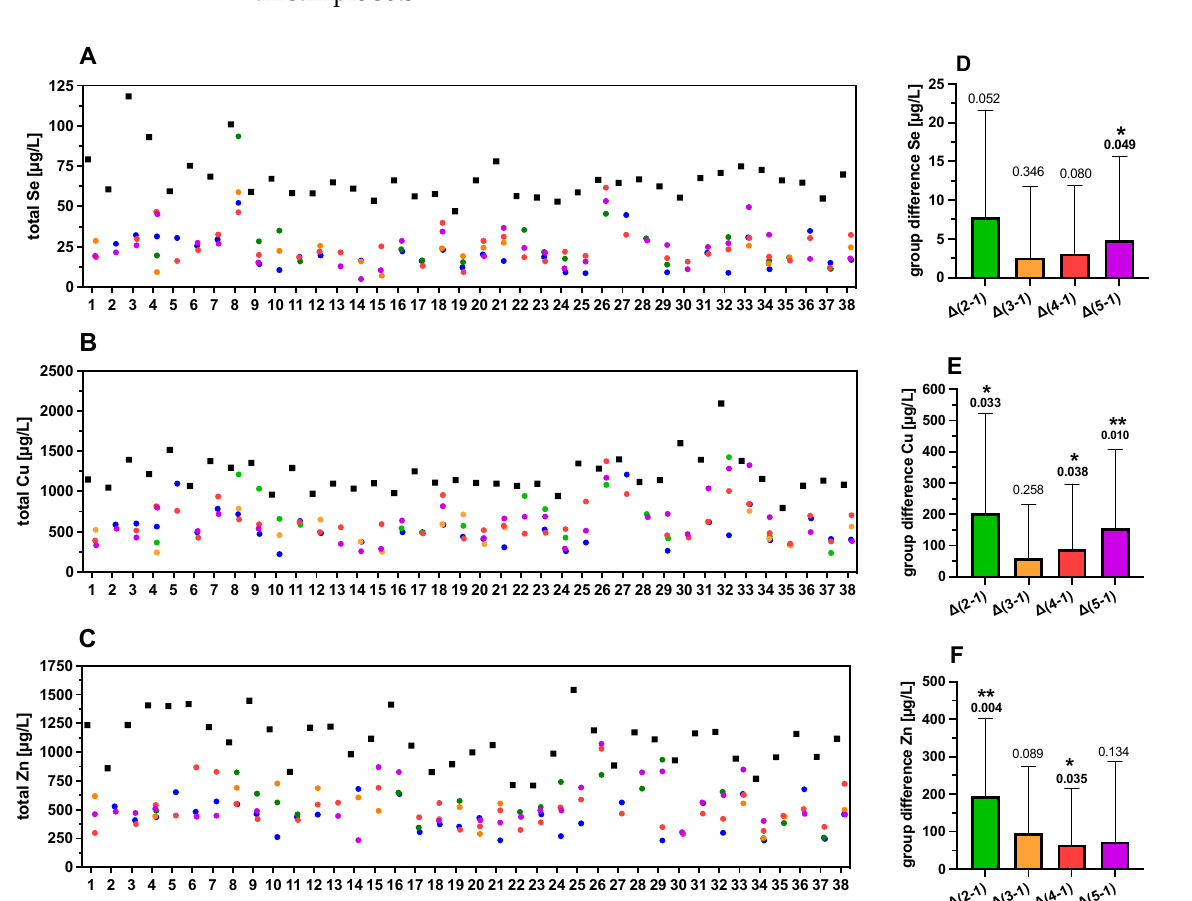
Figure 5. TE concentrations in FF in relation to quality characteristics. The FF are color-coded according to quality characteristics; group 1 (blue, poor quality), group 2 (green), group 3 (orange), group 4 (red), and group 5 (purple, highest quality), as described above (Figure 2). Strong differences between corresponding serum and FF samples and between the different FF of varying quality from the same woman are observed for ( A ) Se, ( B ) Cu, and ( C ) Zn. The mean differences in TE concentrations of the groups of FF with different quality (group differences) with respect to group 1 as reference (poor quality) are indicated for ( D ) Se, ( E ) Cu, and ( F ) Zn. In general, higher TE concentrations are observed in serum than in FF and among the FF with increasing quality. Samples 20–37 correspond to women with PCOS. Statistical significance is indicated by * p < 0.05, and ** p < 0.01.